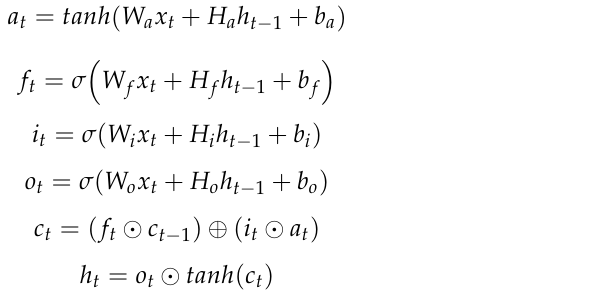
Figure 3. LSTM model with the many-to-many structure. 2.2. Logistic Regression Prediction Model for Many to One Structure In Equation (7), the sigmoid function is used for predicting the output of LR with the inputs features 𝑥 (cid:2869) – 𝑥 (cid:3041) in Equation (8) using model parameters 𝜃 (cid:2868) – 𝜃 (cid:3041) . A conventional run-to-failure LR sets y as a constant to 1 for the initial healthy status, to 0 for failure, and to 0–1 for the rest of the work asset’s lifetime. To build the RUL model accurately with a LR, the difference between the predicted ℎ (cid:3087) (𝑥) and 𝑦 is minimized. Therefore, the model parameters for each 𝜃 (cid:2868) – 𝜃 (cid:3041) are trained based on Equation (7) to predict the actual CV, y, of the machine’s health. The model parameters for 𝜃 (cid:2868) – 𝜃 (cid:3041) can be derived using the Bernoulli distribution, maximum likelihood estimation (MLE), a loss function, and the method of gradient descent.